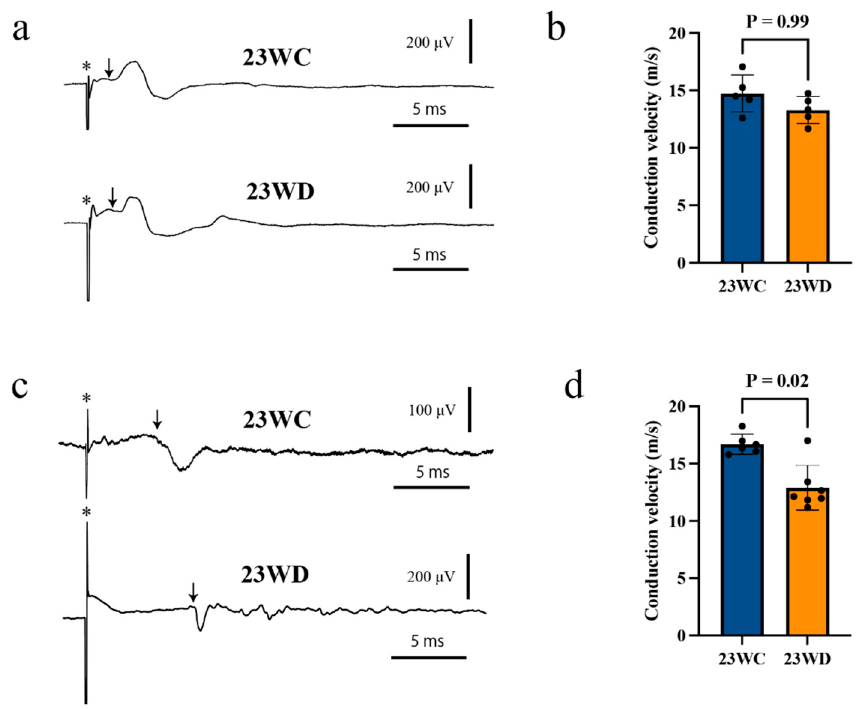
Figure 1. Typical evoked antidromic field potentials of corticospinal tract (CST) neurons. ( a ) Typical hindlimb-area antidromic potentials evoked by C3-segment stimulation in 23WC and 23WD animals. ( b ) There was no significant difference in conduction velocity between diabetic animals and control animals. On the other hand, 23WD showed long-lasting potentials. ( c ) Typical hindlimb-area antidromic potentials evoked by L1-segment stimulation in 23WC and 23WD animals. ( d ) The diabetic animals exhibited decreased conduction velocities and long-lasting multiphasic potentials. Aster- isks indicate stimulus artifacts, and arrows indicate each action potential’s first negative deflection. Abbreviations: 23WC, control animals at 23 weeks after sham diabetes induction; 23WD, diabetic animals at 23 weeks after diabetes